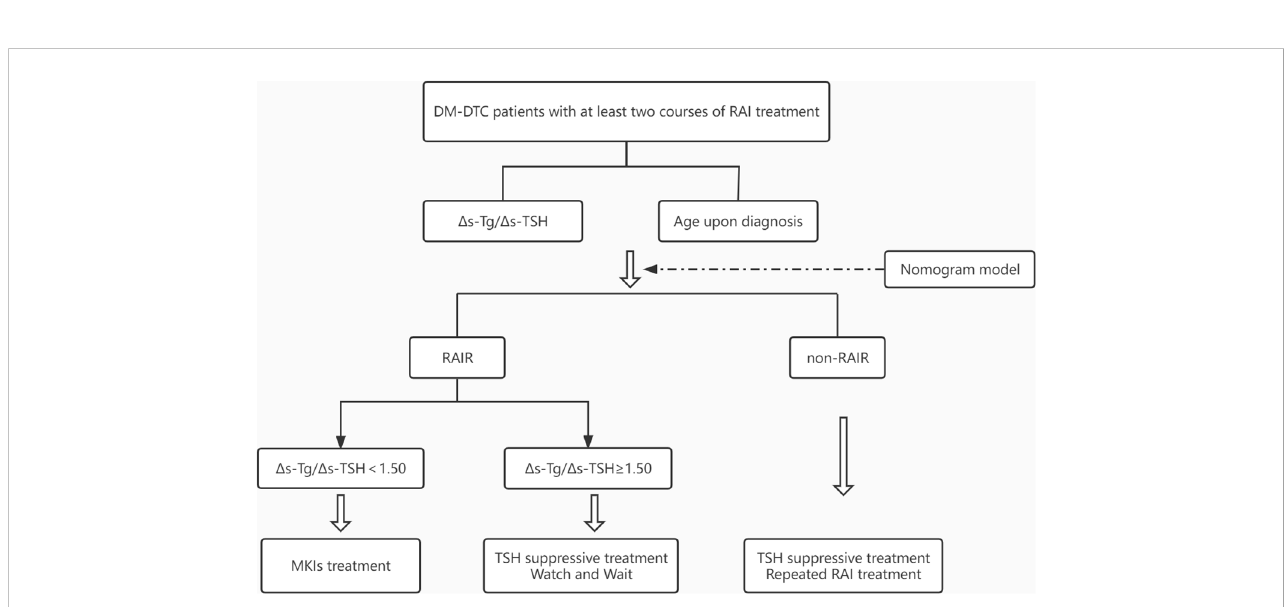
FIGURE 6 Flowchart for predicting RAIR and active surveillance of patients with DM-DTC. DM, distant metastases; DTC, differentiated thyroid cancer; TSH, thyroid stimulating hormone; MKIs, multi-kinase